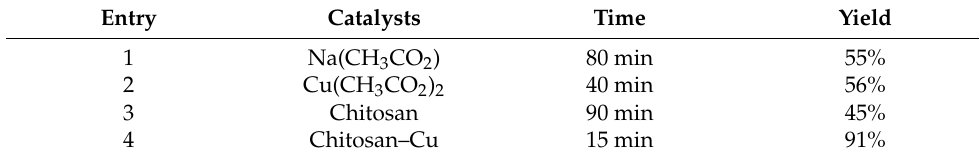
Table 3. Effect of different catalyst on model reaction.